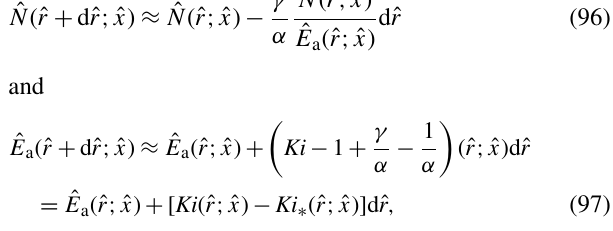
Figure 6. Plot of exceedance probability R ˆ x ( ˆ x ) versus dimension- less travel distance ˆ x showing conditions with fixed net cooling (solid line) and conditions that start with the same cooling rate but then involve a decreasing rate with increasing distance ˆ x (circles). In this example the Kirkby number starts at Ki = 0 . 70 at ˆ x = 0 and increases to Ki = 0 . 96 at ˆ x =